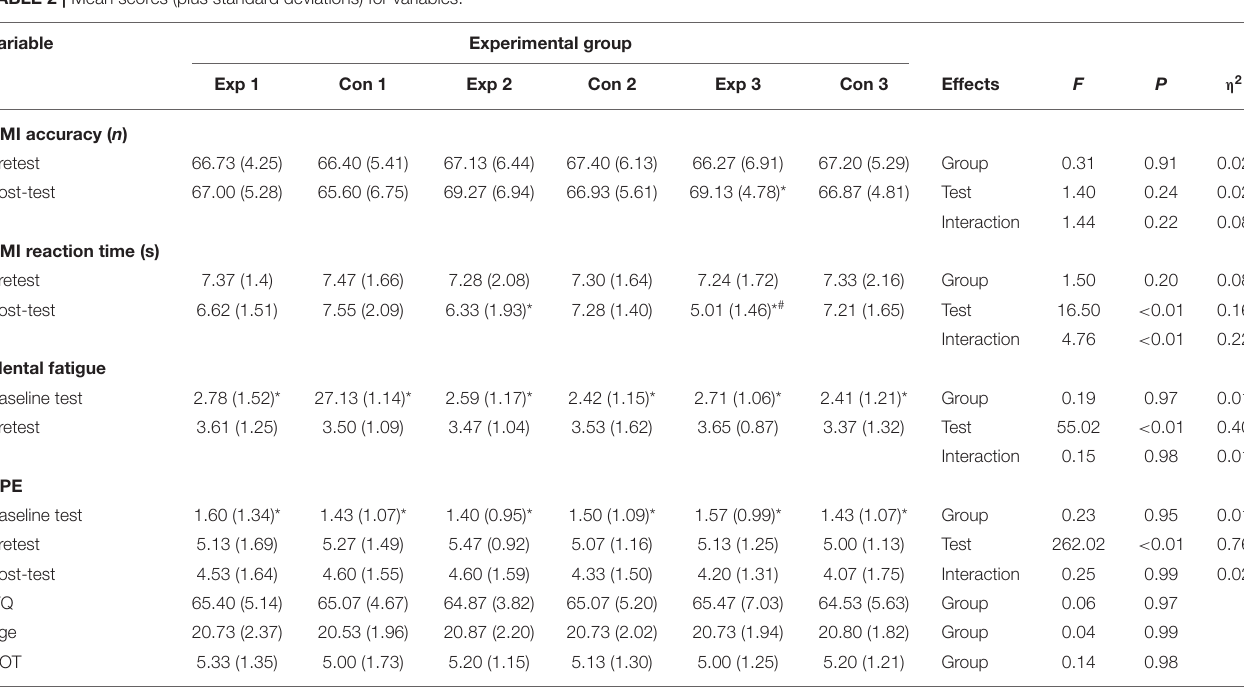
TABLE 2 | Mean scores (plus standard deviations) for